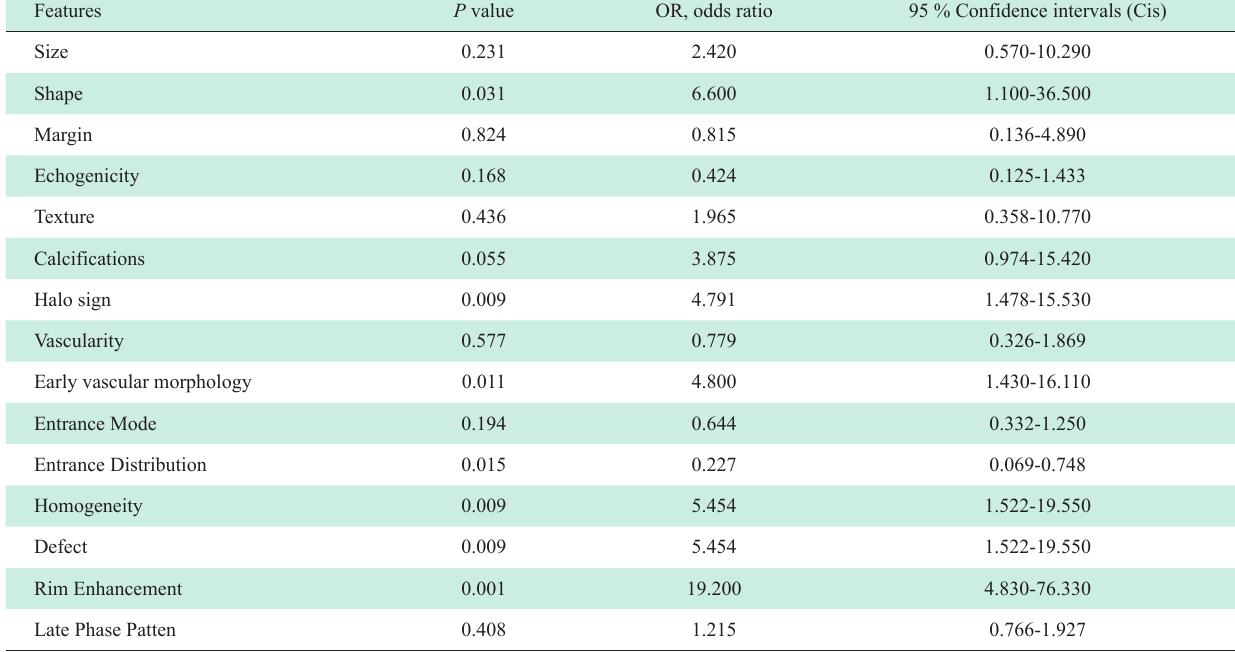
Table 4 The conventional ultrasound and CEUS features predict